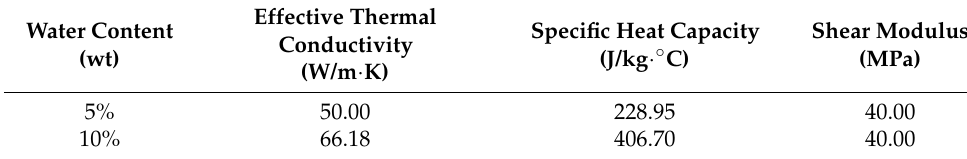
Table 1. Parameters of the particle system.